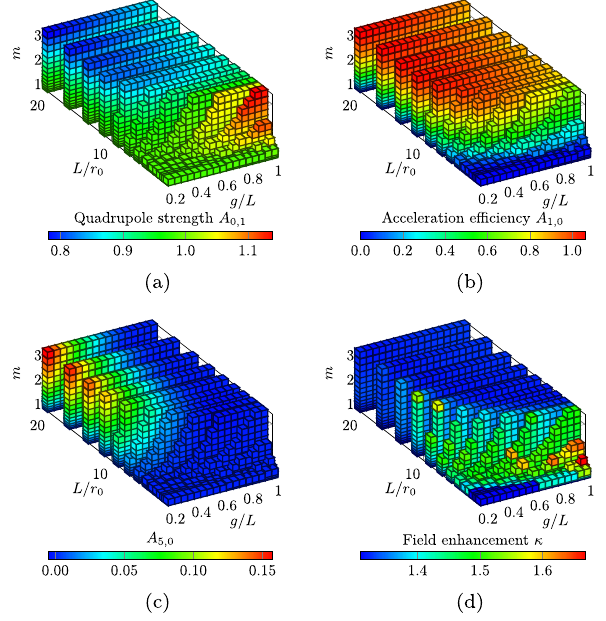
FIG. 11. Computed multipole coefficients as functions of cell length L=r 0 , modulation m , and gap length g=L over the parameter space available to the Carbon-RFQ cells, where ϱ =r ¼ 0 . 9 . Shown are the quadrupole term A 0 0 ; 1 (a), the accel- eration efficiency A 1 (b), a new higher-order longitudinal term ; 0 A 5 (c), and the field enhancement κ ; 0